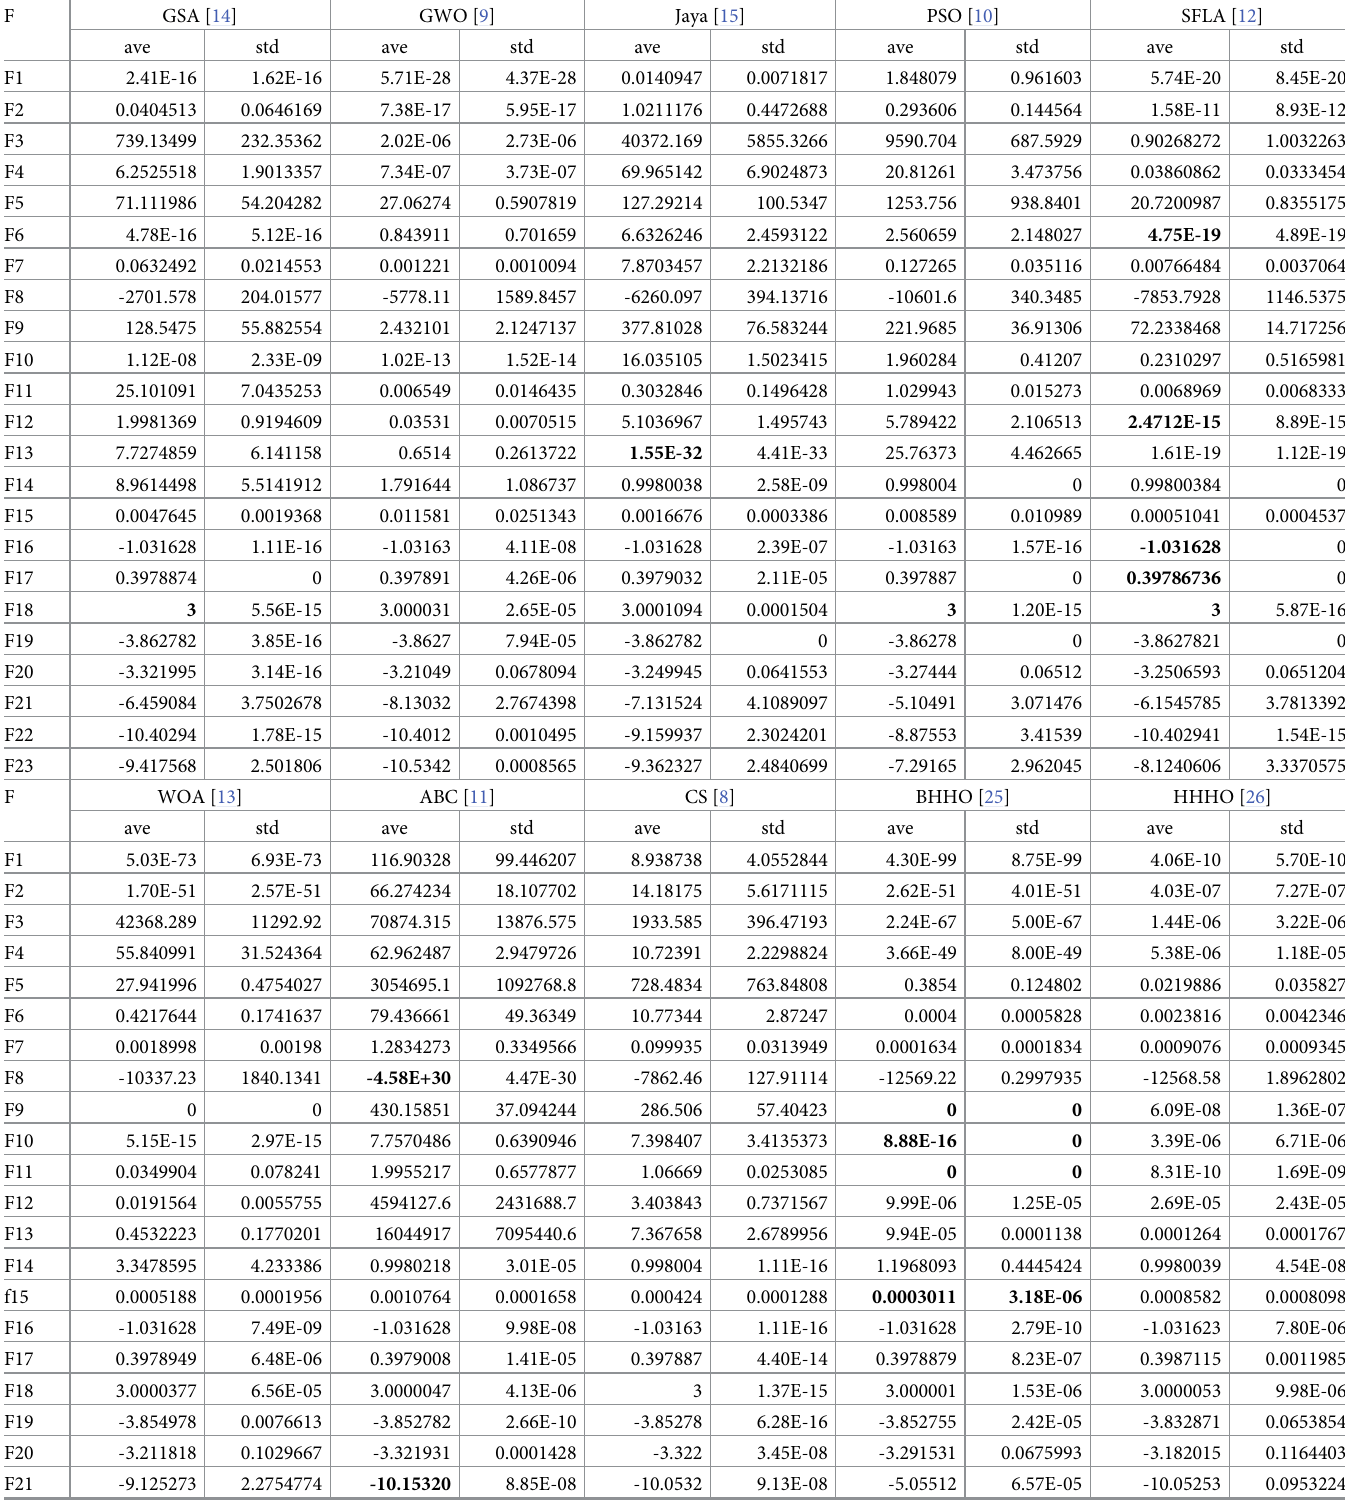
Table 1. Optimization results of 23 benchmark